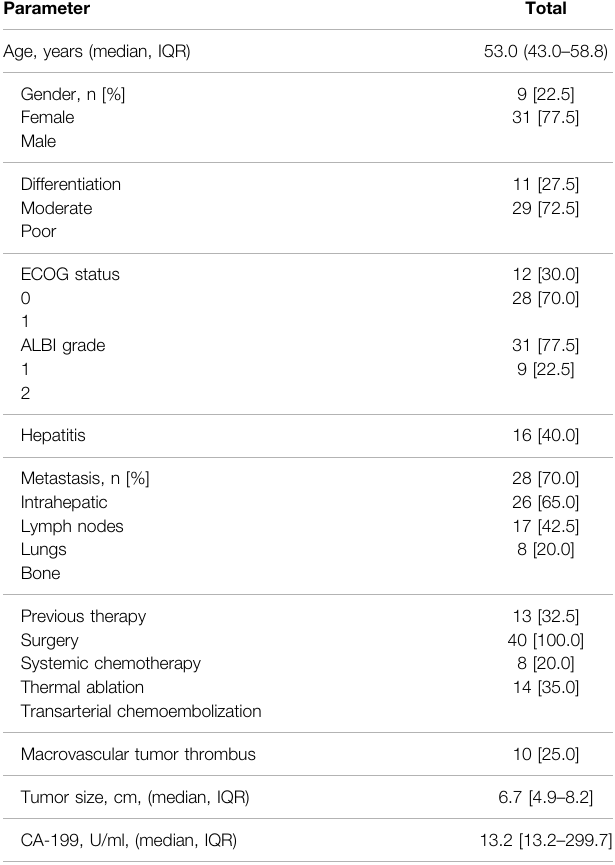
TABLE 1 | Baseline characteristics of patients in the entire cohort.